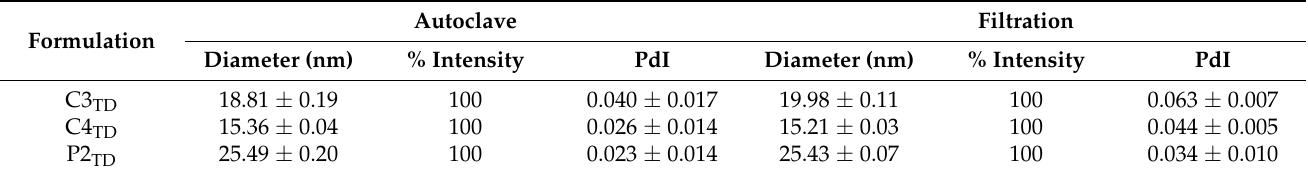
Table 8. Globule size distribution by intensity of 50-fold diluted TD-NEs after sterilization. Formulation